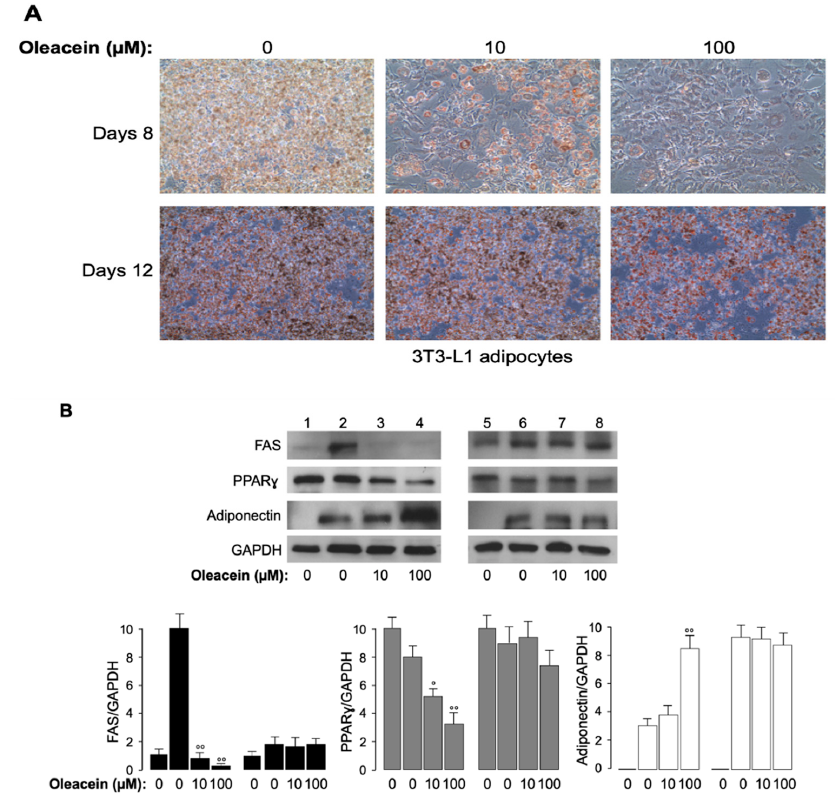
Figure 4. Effects of oleacein on protein expression of adipogenic factors during and after 3T3-L1 adipocyte differentiation. ( A ) Representative images (20×) of cellular lipid droplets in 3T3-L1 treated with increasing concentrations of oleacein during (8 days) and after differentiation (12 days). ( B ) FAS, PPAR γ , and Adiponectin were determined by Western blot in oleacein-untreated and treated cells. GAPDH, loading control. Lanes 1 and 5, 3T3-L1 cells before starting differentiation; lanes 2 to 4, 3T3-L1 cells during di ff erentiation; lanes 6 to 8, 3T3-L1 cells after 12 days di ff erentiation. Each picture is a representative of three independent experiments. Densitometric analysis of proteins on Western blots is shown in the bar graph in each condition. Values are expressed as means ± SD from three separate experiments. ◦ p < 0.05, ◦◦ p < 0.001 vs. oleacein untreated cells (line 2 of Western